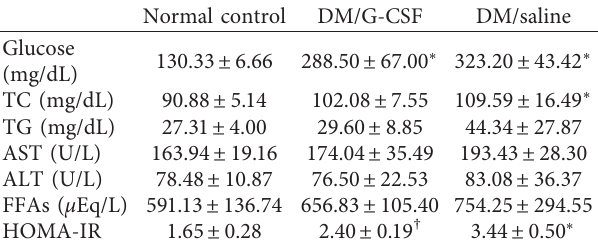
Table 2: Results of serum biochemical analysis 4 weeks after the start of G-CSF or saline treatment.